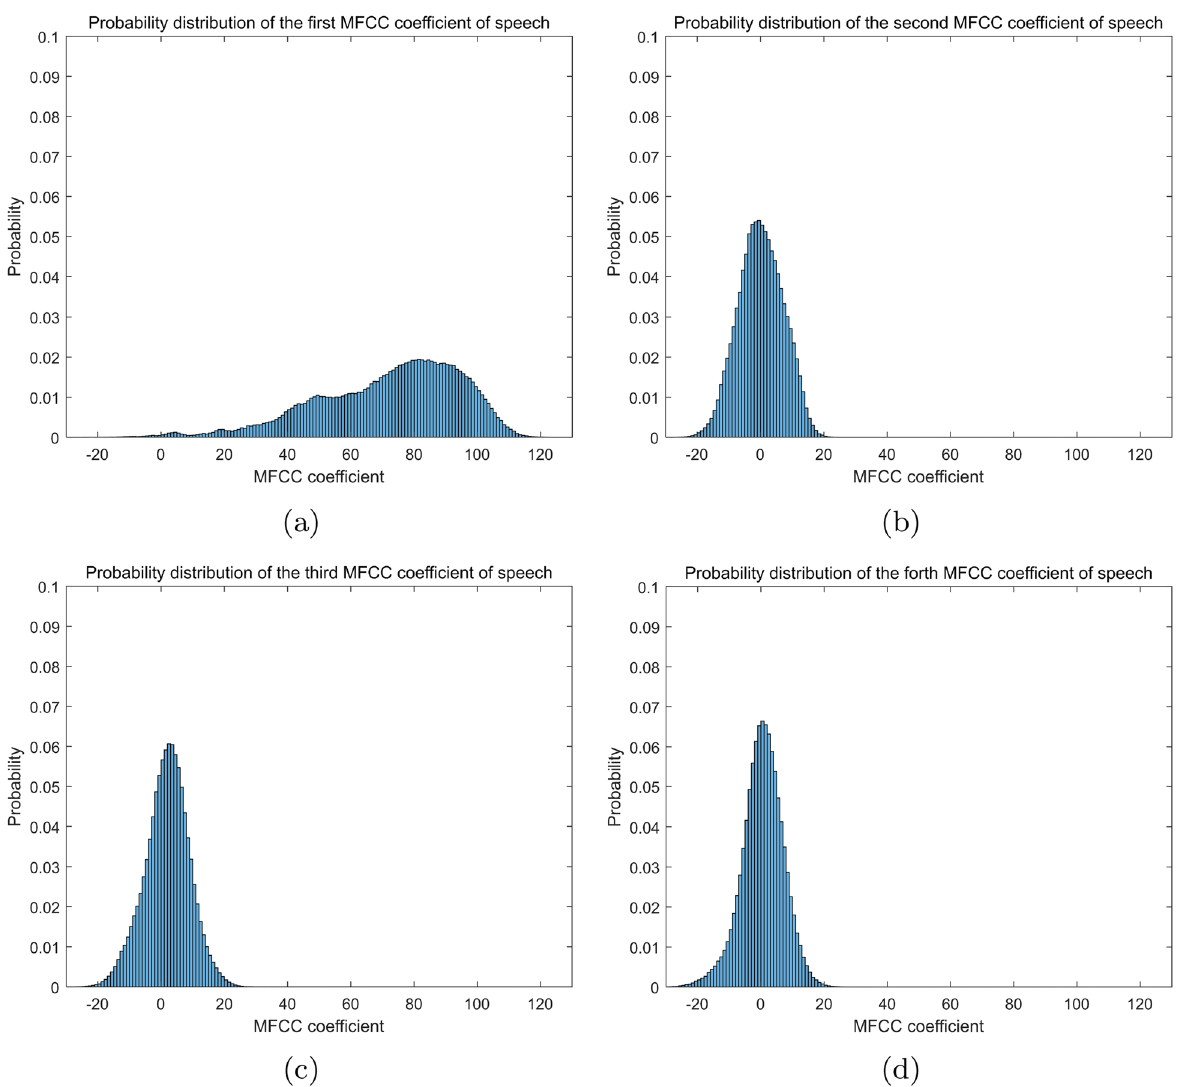
Fig. 2 The probability distributions of the first to fourth